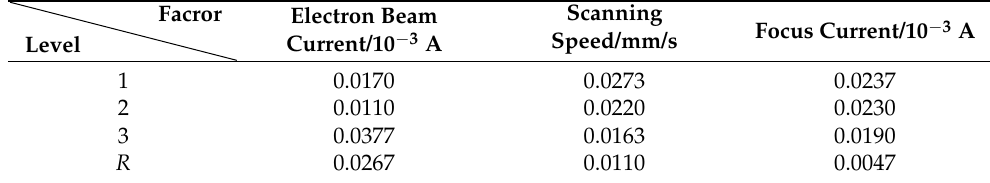
Table 5. K value table of crack areal density.